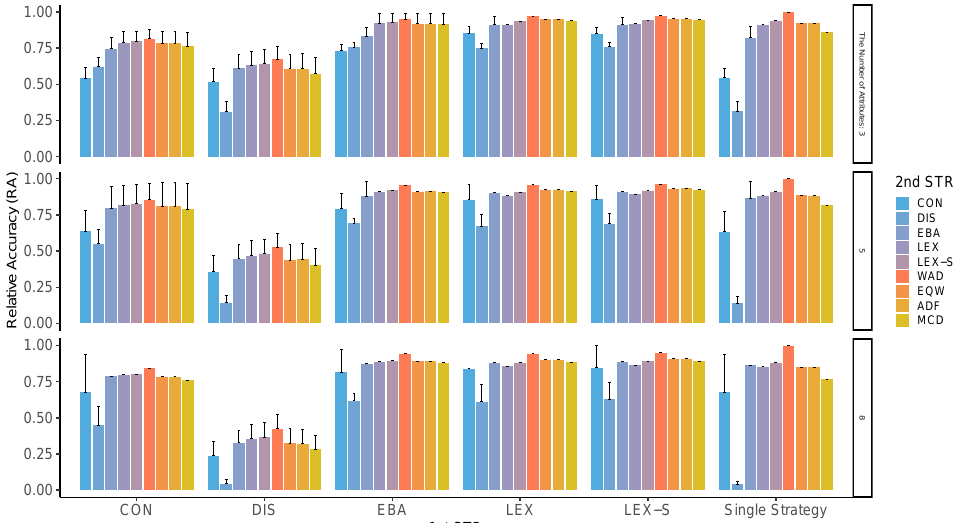
Figure A3. RA in two-stage decision-making when only two alternatives are left in the second stage for the different numbers of attributes. Note: ADF: additive difference; CON: conjunctive; DIS: disjunctive; EBA: elimination by aspects; EQW: equal-weighted strategy; LEX: lexicographic; LEX-S: lexicographic semi-order; MCD: majority of confirming dimensions; STR: strategy; WAD: weighted